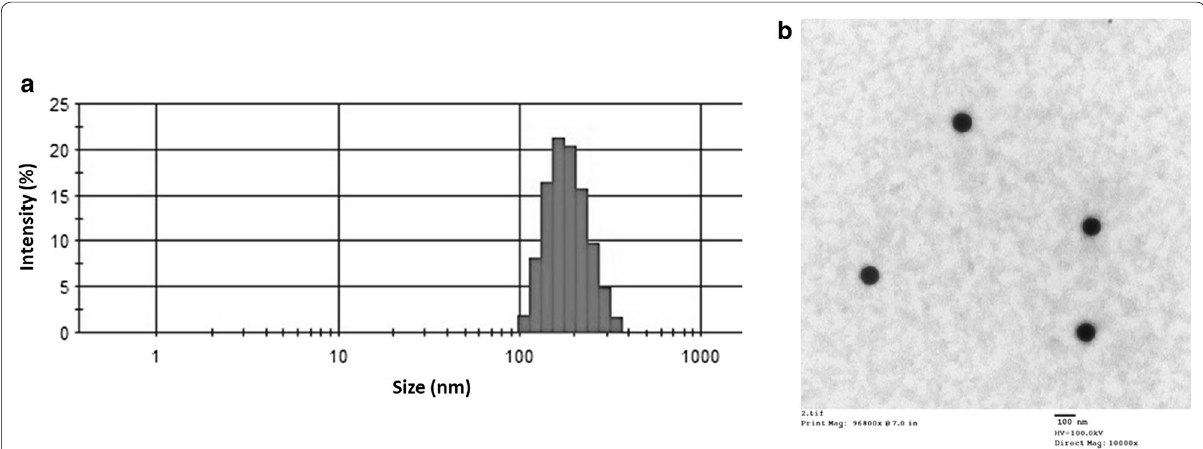
Fig. 2 a Physicochemical characterization of CD/LP‑miCDDP, particle size distribution using dynamic light scattering (DLS); b morphology analysis of CD/LP‑miCDDP using transmission electron microscopy (TEM)